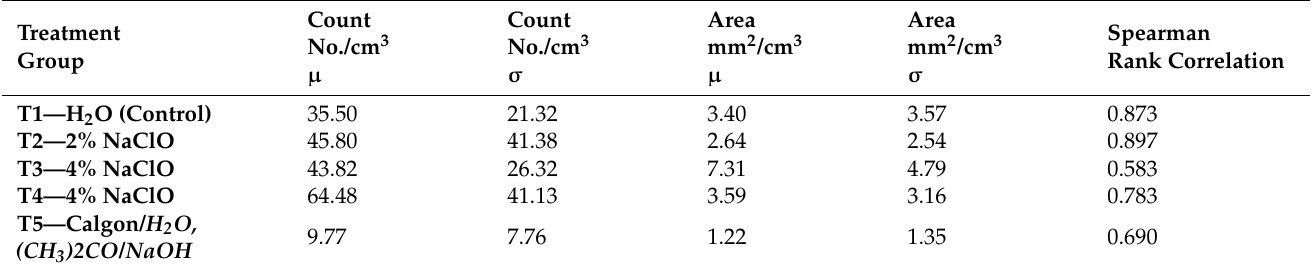
Table 4. Summary statistics of Charring Intensity (CI mean, minimum, maximum, and range) and charcoal concentration (count and area) across the two preparation methods: M1 using water and M2 using dilute bleach. Table 3. One-way ANOVA between groups results for charcoal concentration (as no./cm 3 and mm 2 /cm 3 ) and mean particle size of charcoal (mm 2